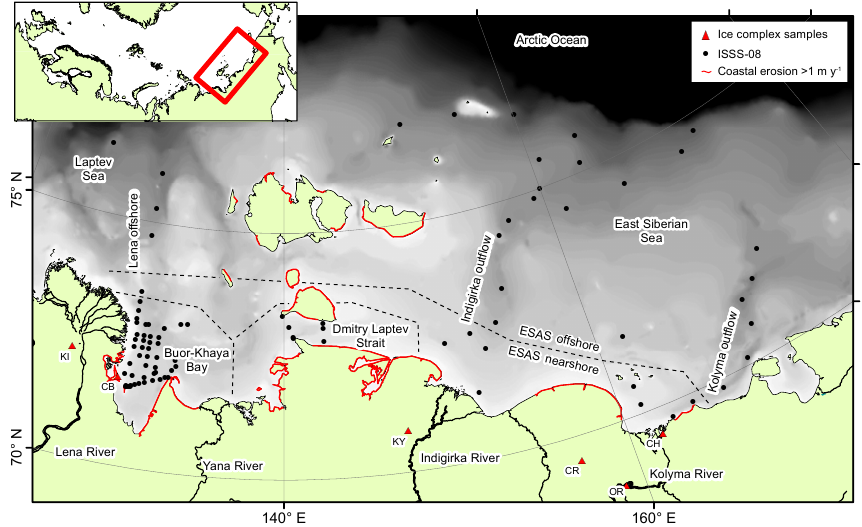
Figure 1. Map of the East Siberian Arctic Shelf (ESAS) showing sampling stations of the International Siberian Shelf Studies 2008 (ISSS-08) expedition and location of Ice complex deposit (ICD) samples investigated in this study. Key regions discussed in the text are highlighted. Lower courses and outflows of four great Russian Arctic rivers are labelled. Section of coastline indicated in red are areas of moderate to high rates of coastal erosion ( > 1myr − 1 ) as defined by Lantuit et al. (2011). Key: KI, Kurungnakh Island; CB, Cape Bykovsky; KY, Indigirka (Tesi et al., 2014); CR, Chukochya River; OR, Omolon River; CH, Cherskii (Tesi et al.,